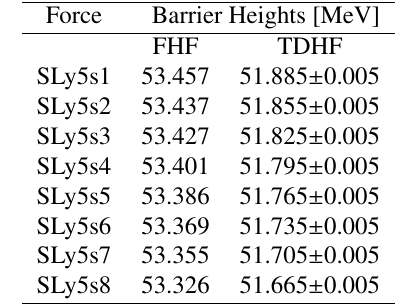
Table 1. Barrier heights for 40 Ca + 48 Ca with FHF and TDHF methods for Skyrme forces SLy5s n for n = 1 .. 8.